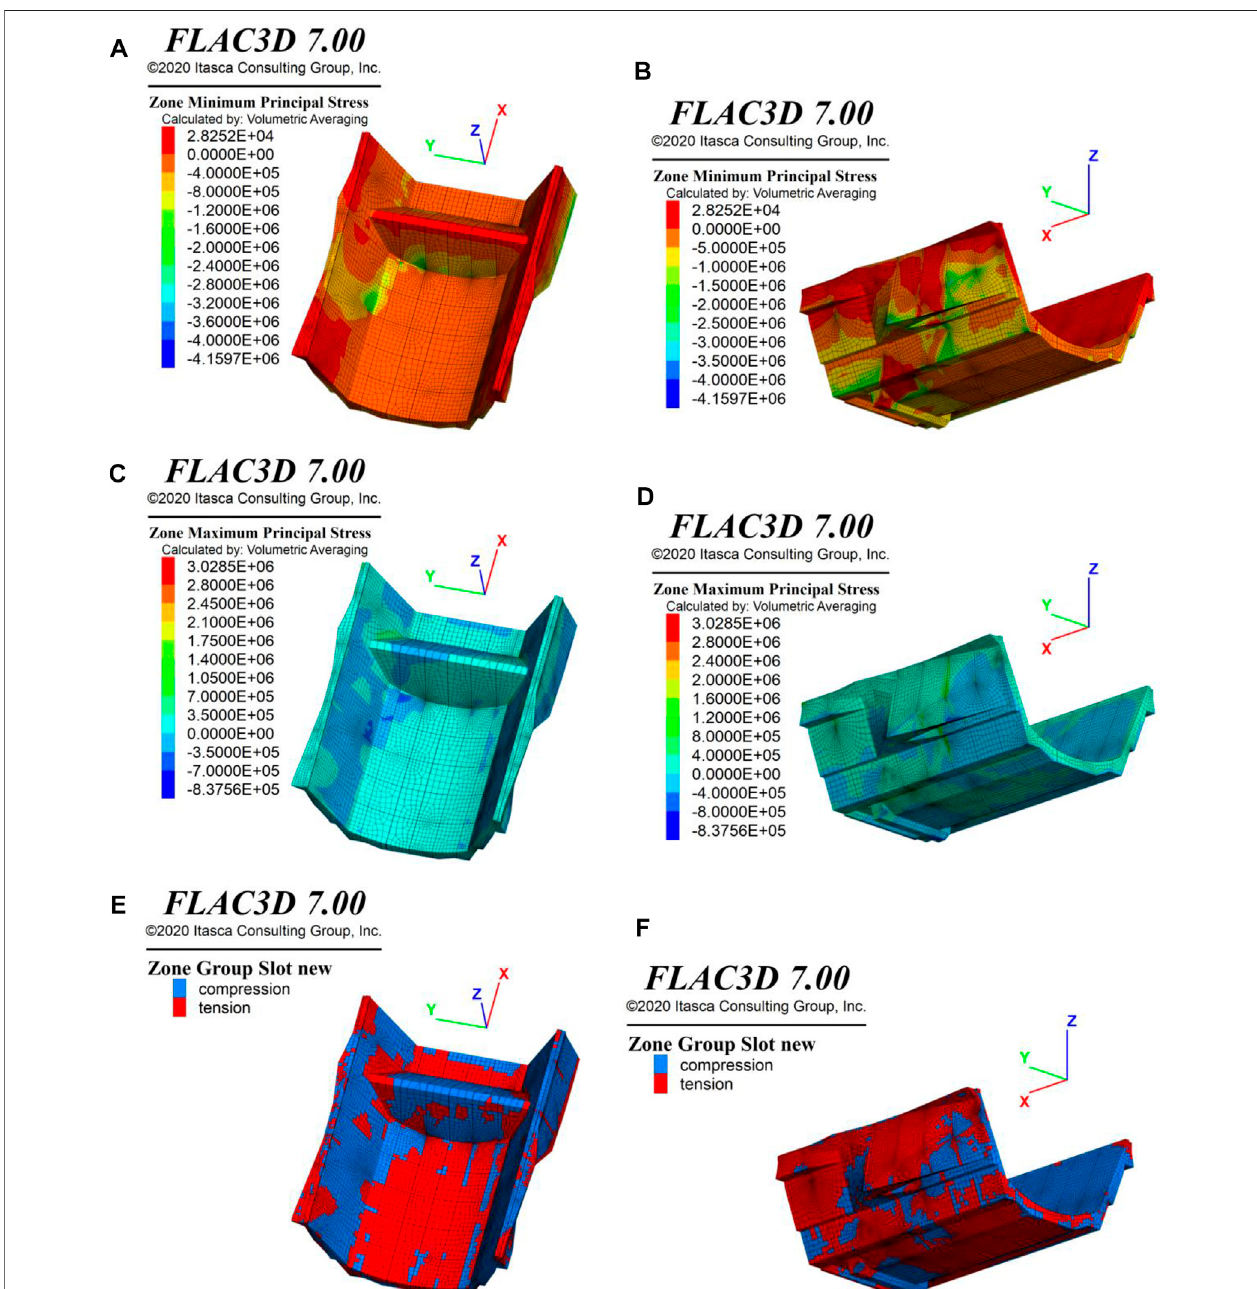
FIGURE7| Numerical modelling stressresults ofstilling basin for working condition ofcheck fl ood: (A,B) Major principal stress, (C,D) Minor principal stress, (E, F) Zones of compression and tension stress.